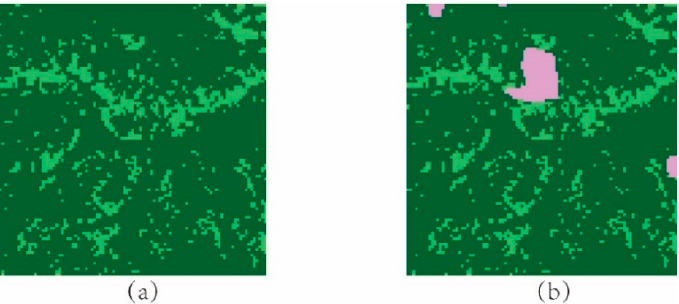
Figure 2. Example of a change in land cover heterogeneity resulting from land cover type conversion: ( a ) Local GlobeLand30 for the year 2000; ( b ) heterogeneity change seen in the year 2010.